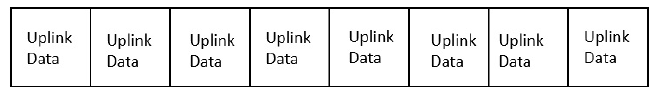
Figure 2. Frame structure—peer-to-peer topology.